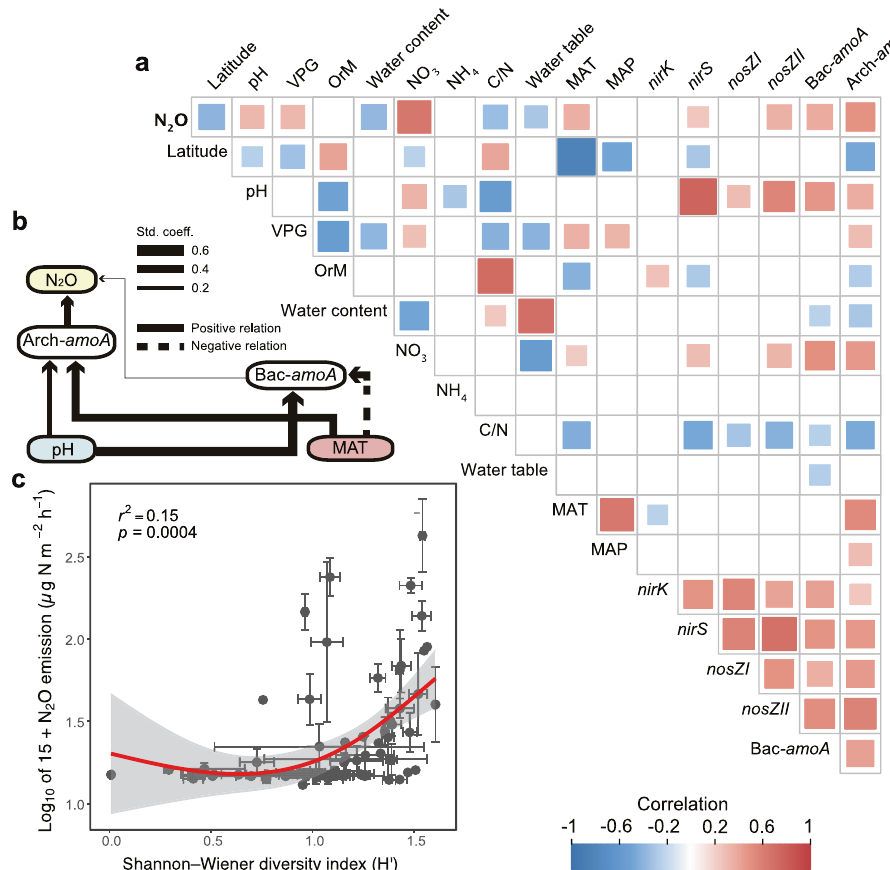
Fig. 4 Nitrogen-cycle genes as the main factors explaining N 2 O emissions across the global wetland soils. a Correlations between environmental variables, the abundance of nir , nosZ and amoA genes (quanti fi ed by qPCR) and N 2 O emission ( n = 74). The abbreviations are archaeal amoA (arch- amoA ), bacterial amoA (bac- amoA ), organic matter (OrM), pH (soil pH), C/N (soil carbon to nitrogen ratio), Von Post grade of decomposition (VPG). b Structural equation modeling (SEM) showing niche differentiation between bacterial and archaeal amoA ( n = 74 independent sites). The model fi tness was acceptable (Fisher ’ s C = 8.4, p = 0.08). Line thickness corresponds to standardized regression coef fi cients as indicated in the legend. Dash lines indicate negative relationships. The statistical test used was two-sided. The abbreviations are mean annual temperature (MAT), pH (soil pH). c Relationship between N 2 O emissions and the diversity of N cycle functional genes that are directly involved in N 2 O dynamics, including archaeal amoA , bacterial amoA , comammox amoA, nirK, nirS, nrfA, nosZI , and nosZII . The inset numbers represent an adjusted r 2 and p -value from a GAM model. Error bars represent the standard error (SE) of the means ( n = 74 independent sites). The statistical test used was